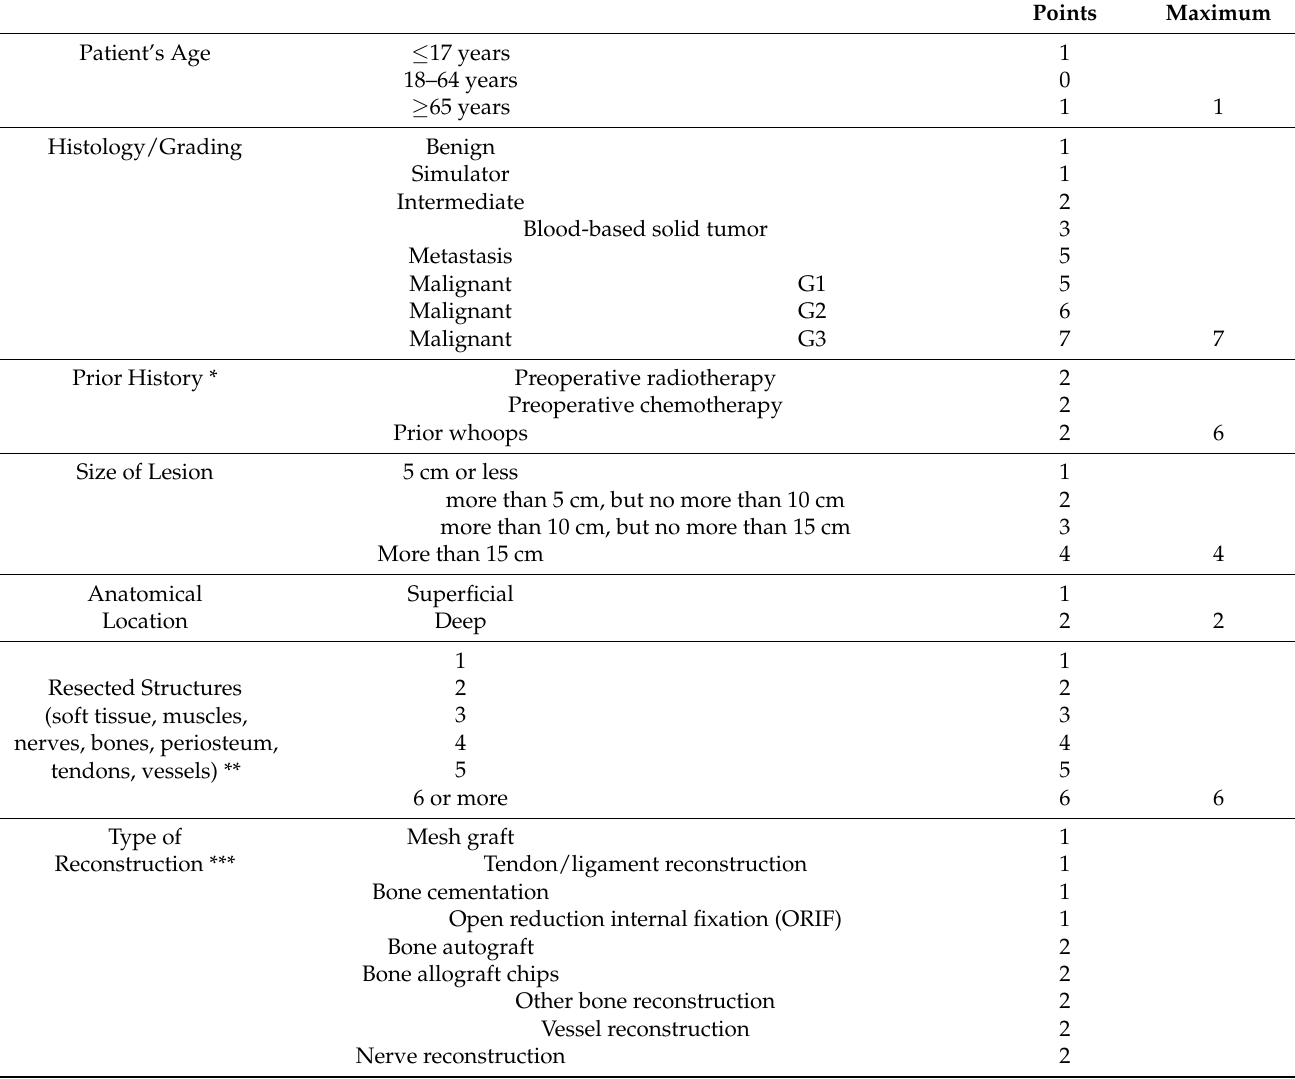
Table 1. STS-SCS system indicating the weighting of each